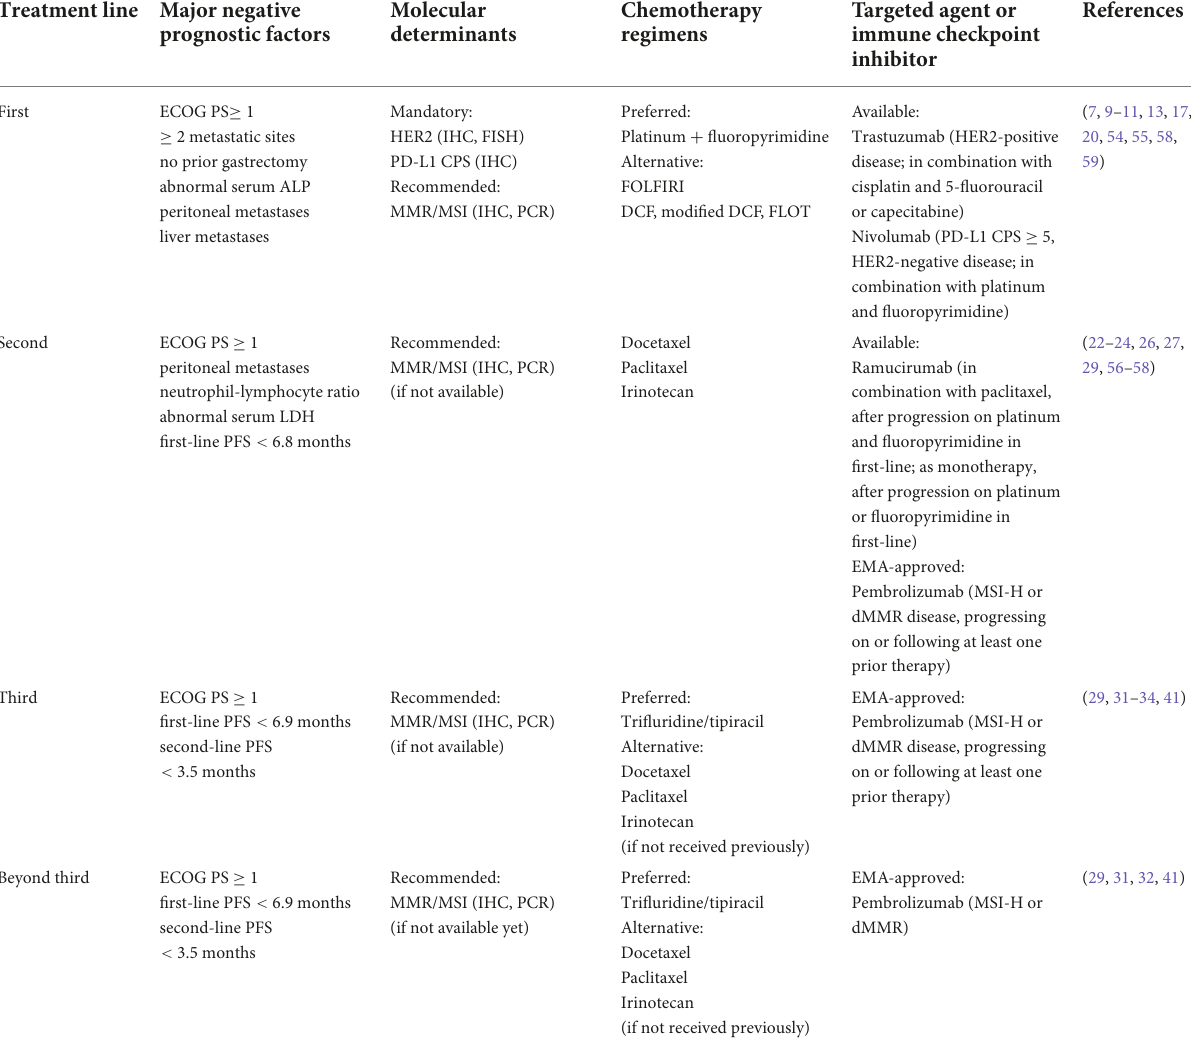
TABLE 1 Summary of currently available treatment options and major clinical prognostic determinants in metastatic gastric